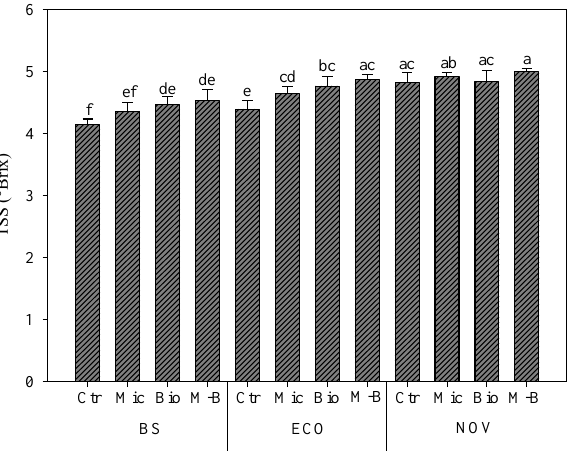
Figure 4. Total Soluble Solid (TSS) content of tomato fruits as affected by interaction mulching (ECO: biodegradable film Ecovio; NOV: biodegradable film MaterBi ® ; BS: bare soil) and biostimulant ap- plication (Bio: treated with Phylgreen ® ; Mic: treated with Trianum-P ® ; M-B: combination of Bio and Mic; Ctr: not treated). Each column indicates the mean value of the three replicates. Vertical bars indicate standard error; different letters indicate significant differences according to Tukey’s test ( p < 0.05).